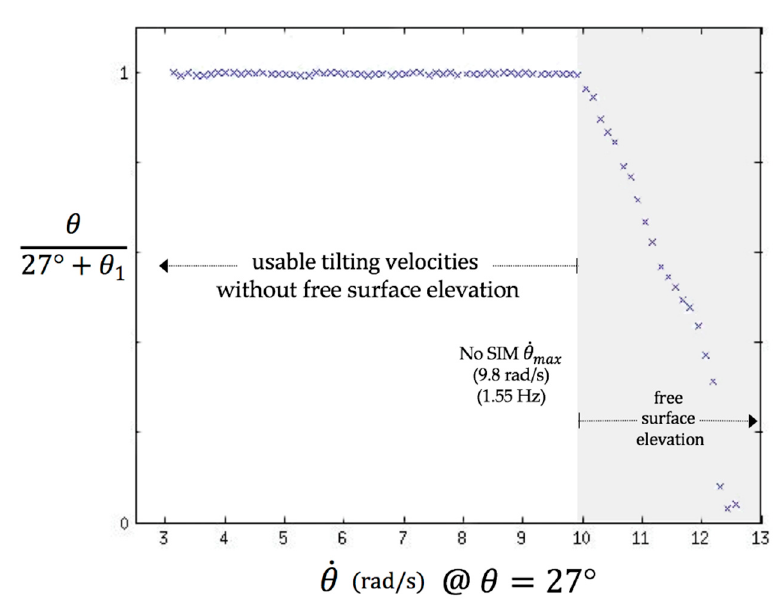
Figure 12. Usable full cycle tilting velocities ω in the case of AFS without SIM.